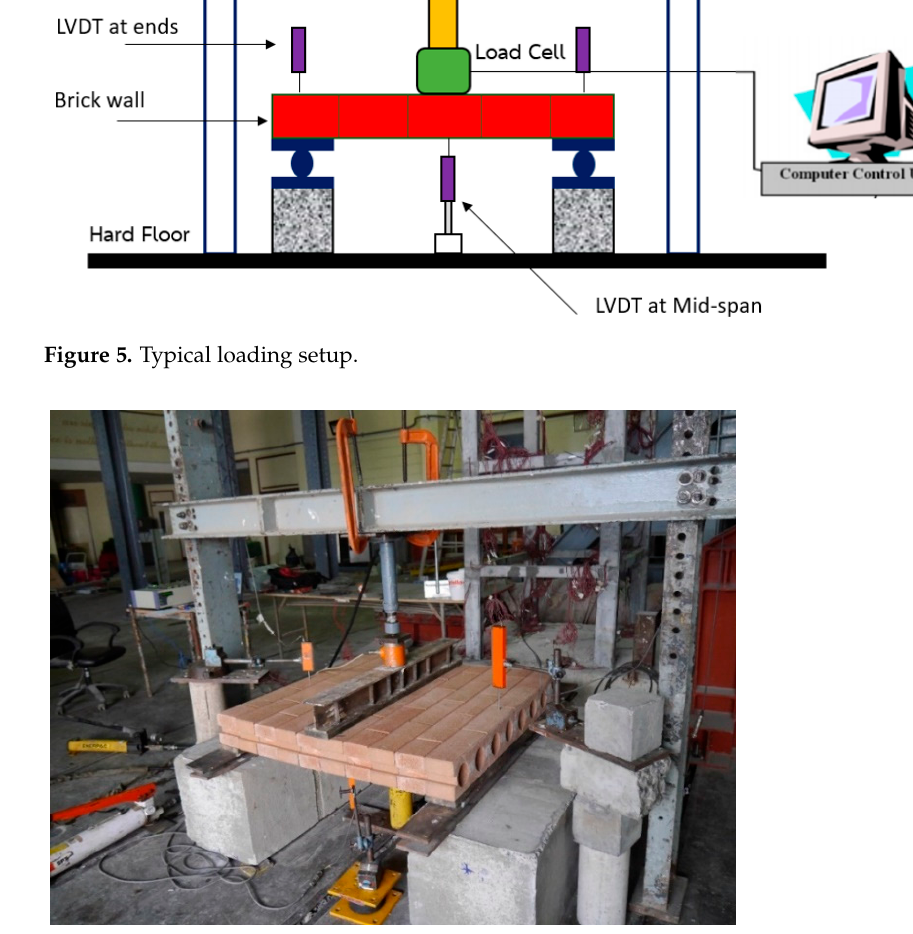
Figure 6. Loading setup (laboratory view).